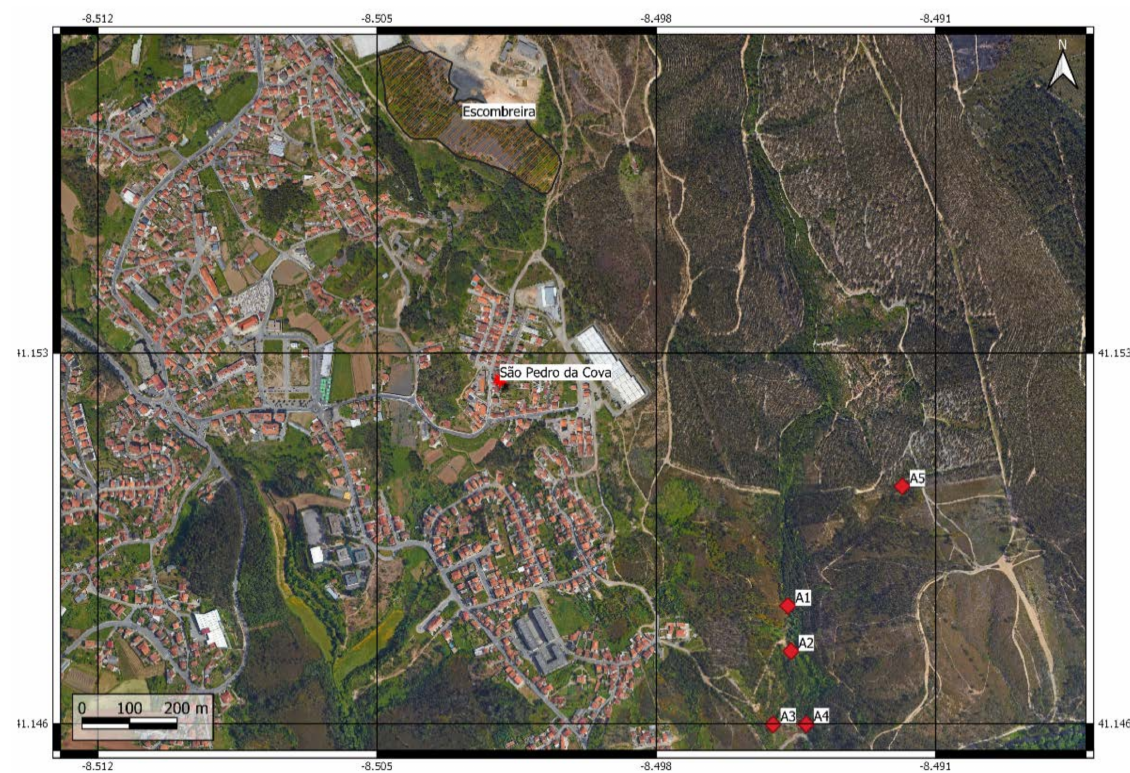
Figure 4. Water samples